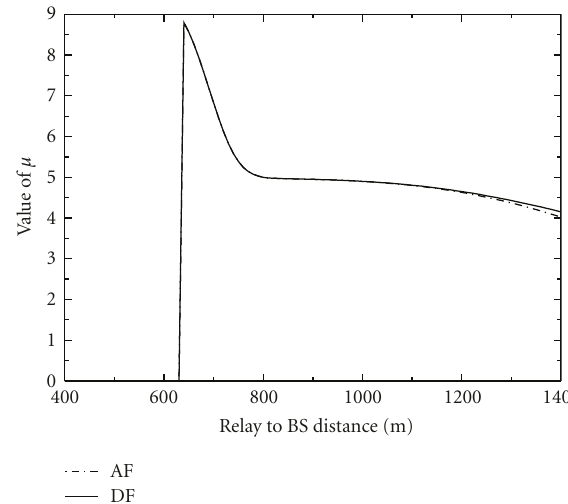
Figure 7: Changing value of μ versus di ff erent locations of the relay.